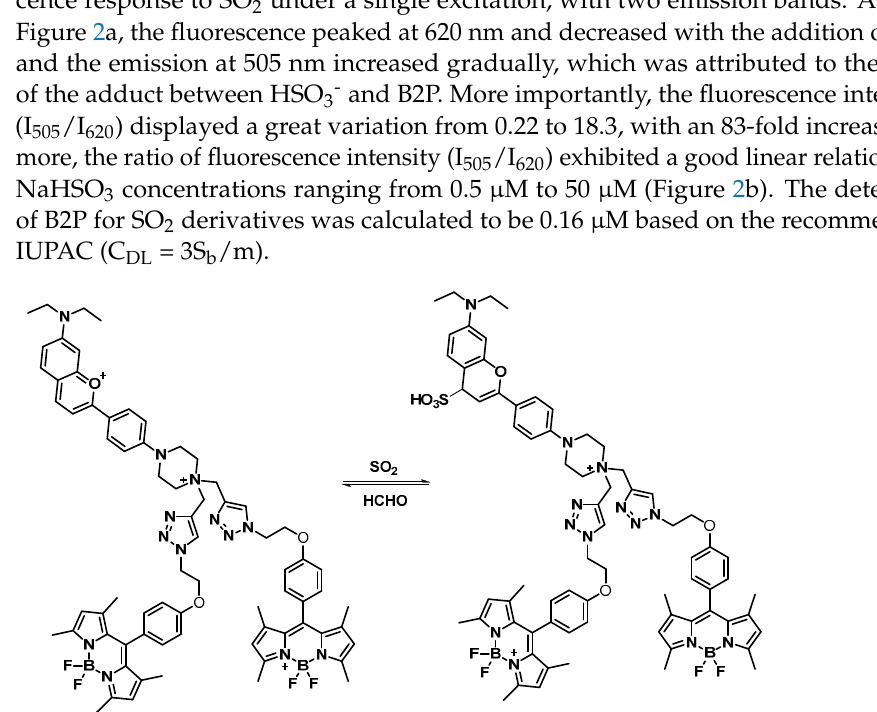
Figure 2. ( a ) Fluorescence spectra of probe B2P (10 μ M) in the presence of different concentrations of NaHSO 3 ; ( b ) the relationship between the fluorescence ratio (I 505 /I 620 ) and the concentration of NaHSO 3 ; ( c ) fluorescence ratio (I 505 /I 620 ) of probe B2P in the presence of different analytes (200 μ M); ( d ) fluorescence spectra of the B2P–HSO 3 adduct (10 μ M probe and 100 μ M NaHSO 3 ) in the presence of different concentrations of FA; ( e ) the recovery efficiency of the fluorescence ratio (I 620 /I 505 ) of probe B2P–HSO 3 in the presence of different aldehydes, oxidizing substances and other analytes (400 μ M); ( f ) the fluorescence ratio (I 505 /I 620 ) in the reversible cycle of B2P under alternate additions of NaHSO 3 and FA.